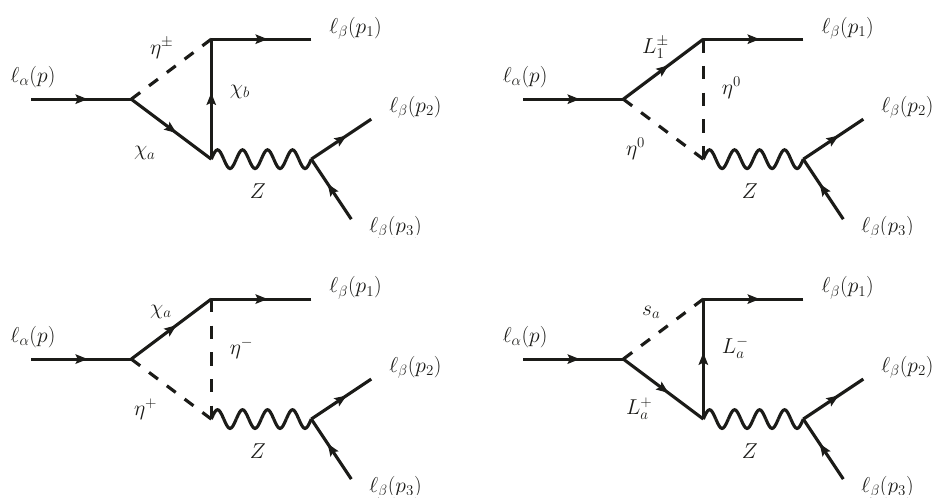
decay. Leg corrections → ‘ − ‘ − ‘ + α β β β ), 0 , 1 (for χ ) and s = η 0 , s = S a,b 1 2 a,b